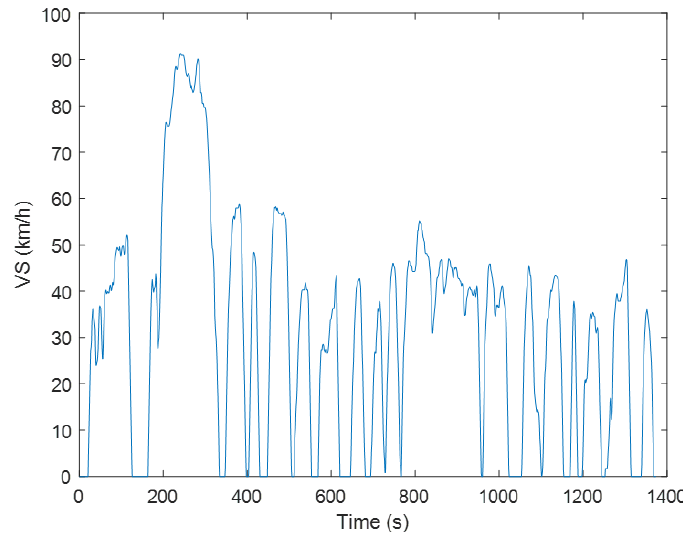
Figure 6. FTP-72 driving cycle.